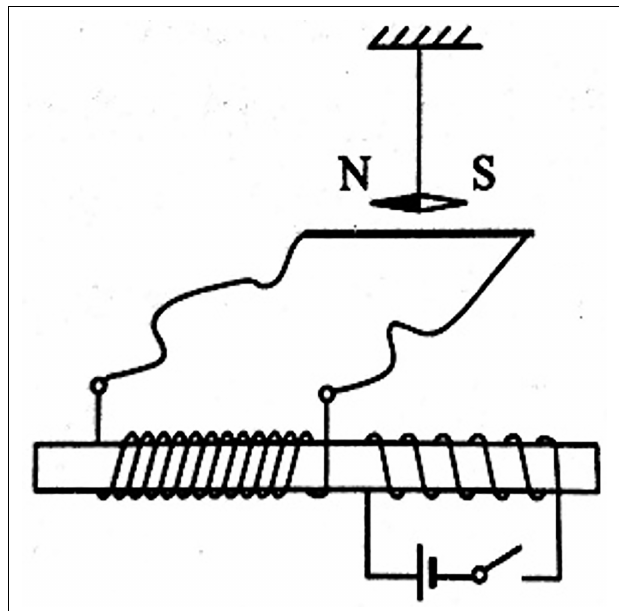
FIGURE 2 | The circuit of example question that examines the attribute “Lenz’s law: